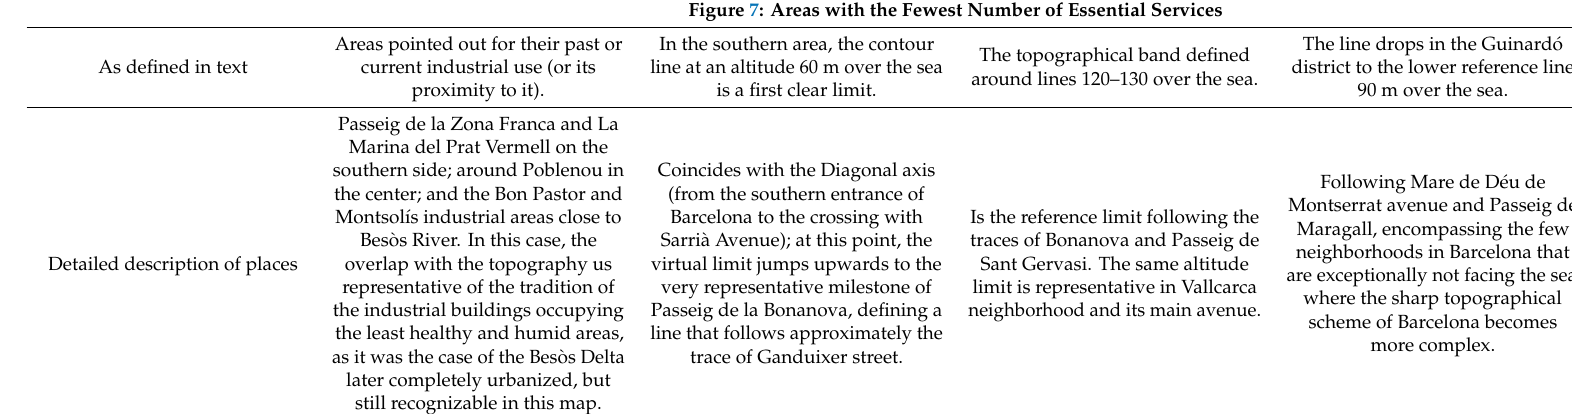
Table A2. Detailed description of places referenced in Figure 7. Figure 7: Areas with the Fewest Number of Essential